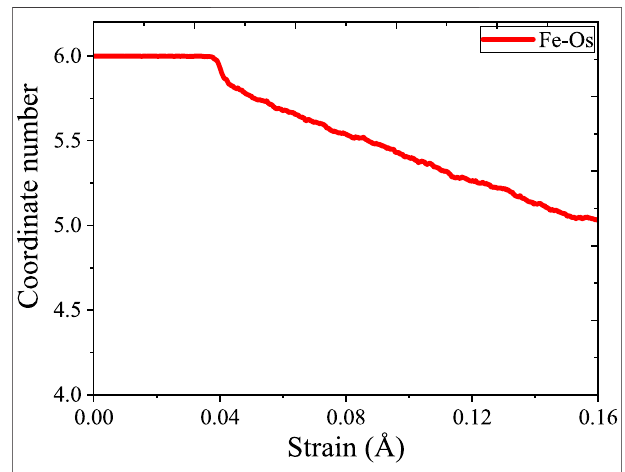
FIGURE 10 | (A) 100 ps, (B) 190 ps, (C) 200 ps, and (D) 400 ps γ -Fe 2 O 3 structure Fe atom coordination map. Among them, green represents iron with a coordination number of 5, purple represents iron with a coordination number of 4, and pink represents iron with a coordination number of